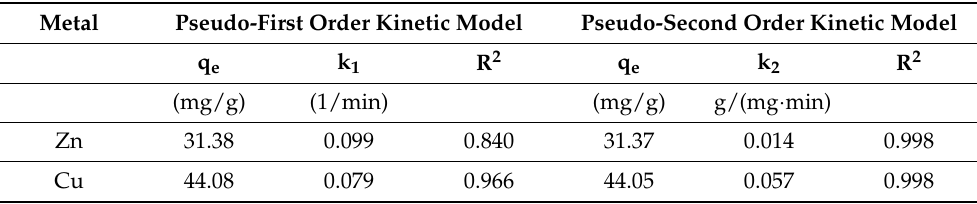
Table 2. Comparison of the pseudo-first and pseudo-second order kinetic models for the sorption of Zn and Cu onto the synthesized material (“synt”